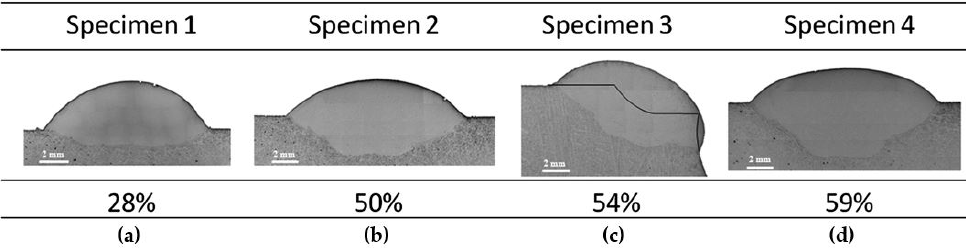
Figure 4. A PTA coating showing increase in dilution by GCI from ( a ) 28%; ( b ) 50%; ( c ) 54%; and ( d ) 59% with increase in arc intensity [70]. Reprinted with permission from [70]. © 2011 Elsevier.